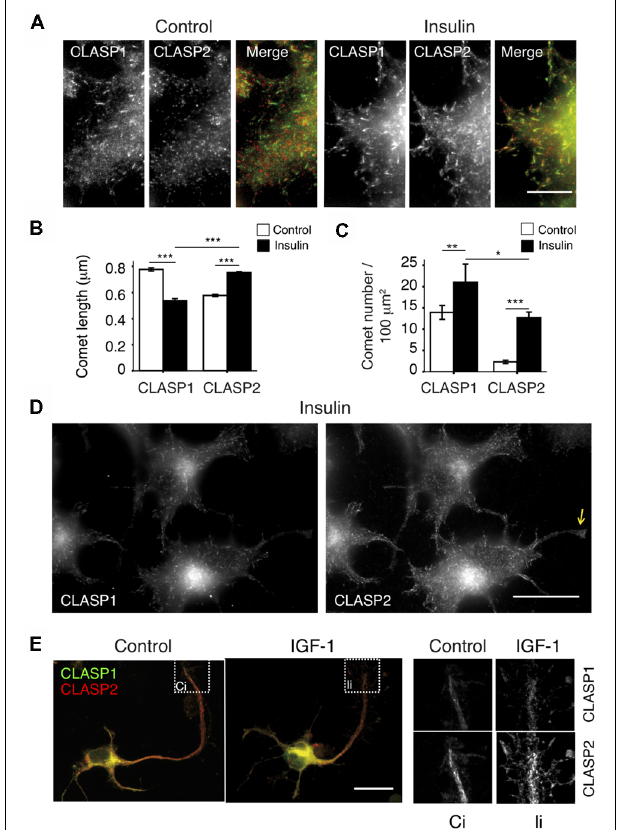
FIGURE 3 | Differential regulation of CLASP1 and -2 by Insulin and insulin-like growth factor-1 (IGF-1). (A) Insulin regulates CLASP1 and -2 distribution differently. Serum-starved N1E-115 cells were either treated with vehicle (Control) or insulin (2 µ g/ml for 10 min), and subsequently fixed and stained with antibodies against CLASP1 (green in merge) and CLASP2 (red in merge). Double IF confocal images of endogenous CLASP1 and CLASP2 at edges of control and insulin-treated cells are shown. Scale bar = 20 µ m. (B,C) Quantification of MT plus-ends. Average CLASP comet lengths (B) or MT density (number of MT plus-ends stained by CLASPs per 100 µ m 2 , C ) before and after insulin addition are depicted ± SEM. Comets were compared in Control cells vs. Insulin-treated cells for each CLASP. CLASP1 and CLASP2 comet lengths and density were also compared post-treatment. ANOVA tests were performed. (D) CLASP2, but not CLASP1, localizes prominently in neurite tips and growth cones in insulin-treated N1E-115 cells, as shown in serum starved cells, fixed and stained with anti-CLASP1 and CLASP2. Yellow arrow points to a neurite tip. Scale bar = 20 µ m. (E) IGF-1 induces CLASP2 relocalization to enlarged growth cones in 1DIV mouse HNs. Neurons were fixed and stained with anti-CLASP1 (green in merge) and anti-CLASP2 (red in merge). Insets show details of CLASPs localization in growth cones in control (Ci) and IGF-1-treated (Ii) neurons. Scale bar = 20 µ